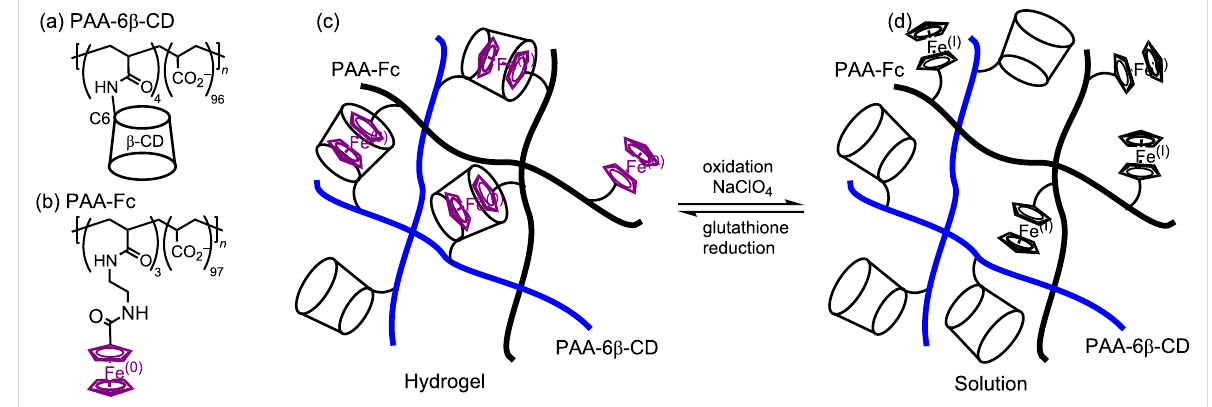
Figure 23: (a) Randomly β -CD substituted poly(acrylate), PAA-6 β -CD. (b) Randomly ferrocenyl substituted poly(acrylate), PAA-Fc. (c) PAA-6 β -CD/ PAA-Fc hydrogel. (d) PAA-6 β -CD/PAA-Fc solution after ferrocenyl iron(0) oxidation to ferrocenium iron(I) [110].